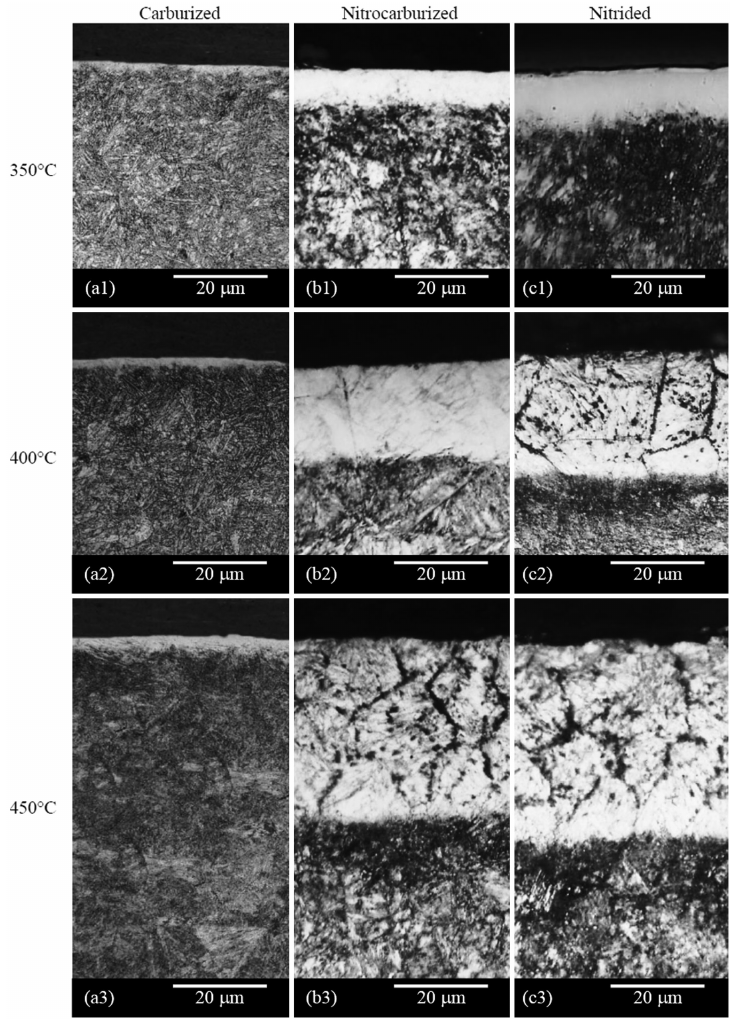
Figure 1. Cross-section micrography of samples carburized, nitrocarburized and nitrided at 350, 400 and 450